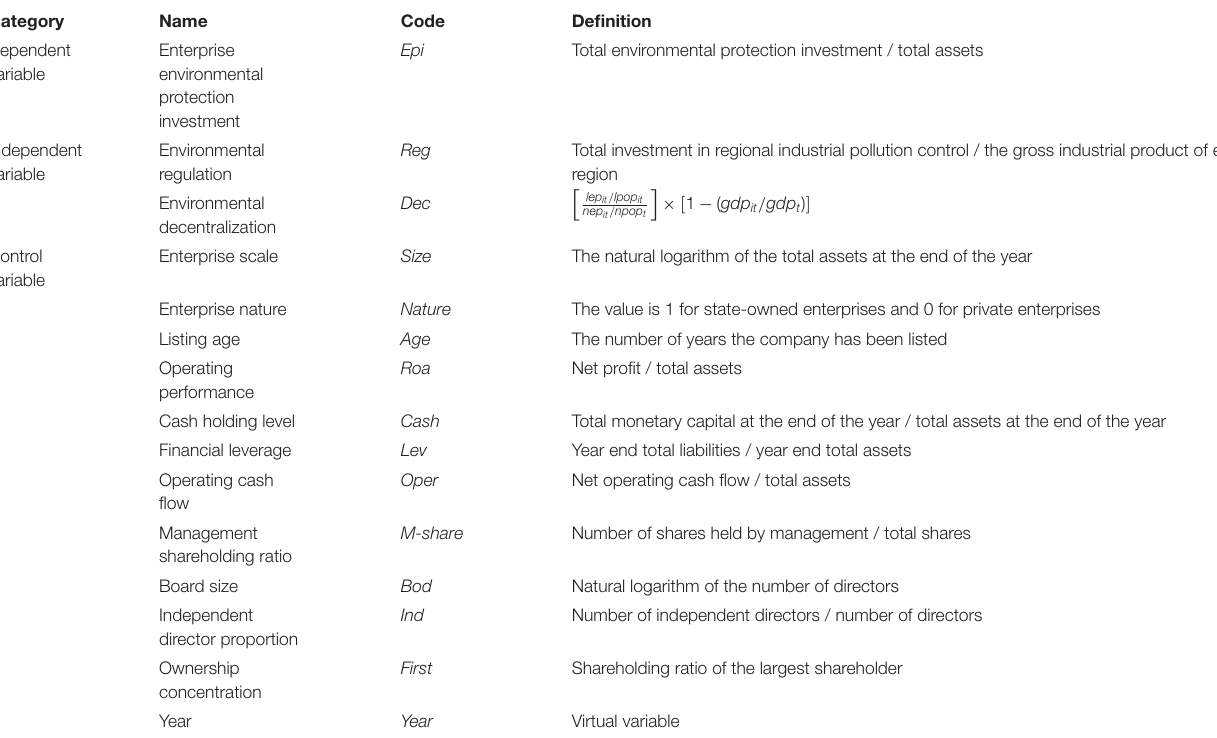
TABLE 1 | Definition of variables.